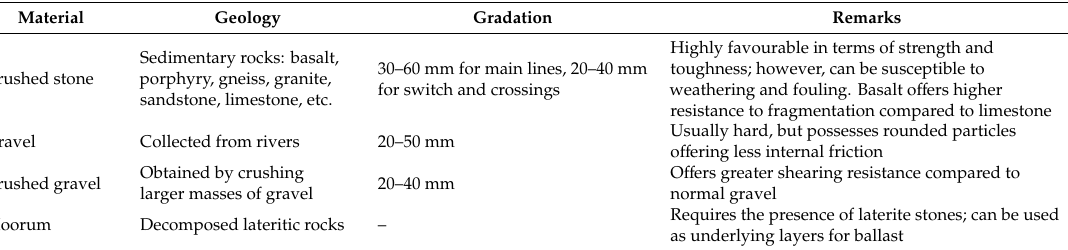
Table 1. Description of commonly utilised ballast bed materials